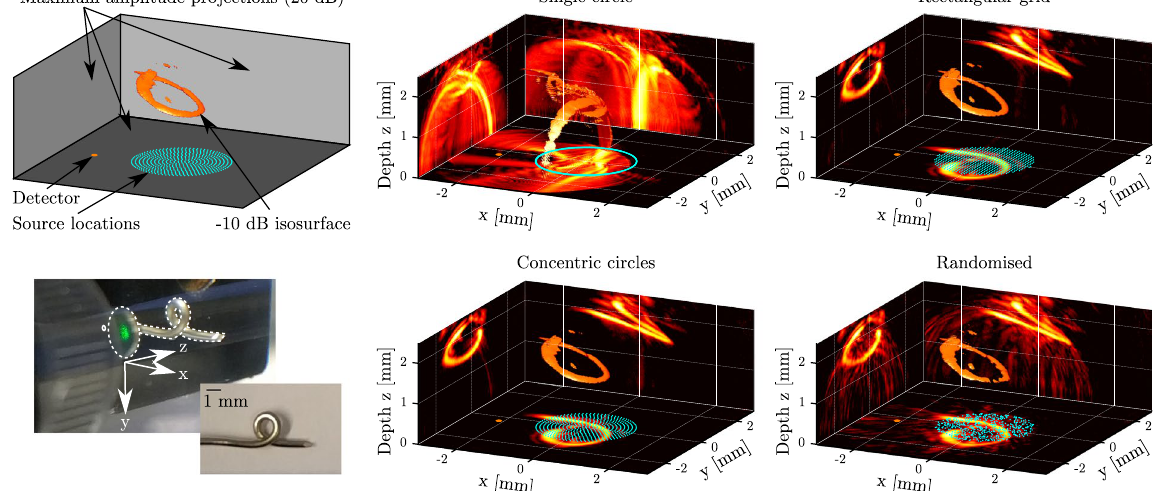
Figure 5. Three-dimensional (3D) images obtained with the all-optical pulse-echo imaging system using four different excitation patterns. A twisted metal wire (bottom left) was used as phantom. A similar visualisation and the same excitation patterns as in Fig. 3 were used; source locations are indicated in light blue, the receiver in orange, and the three panels show maximum amplitude projections on a logarithmic scale with a 20 dB dynamic range. The 3D volumetric renders show the − 10 dB isosurfaces.